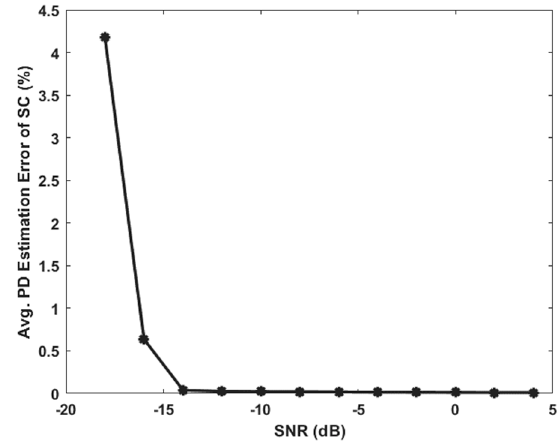
Figure 14. Average PD estimation error versus SNR for the SC algorithm.